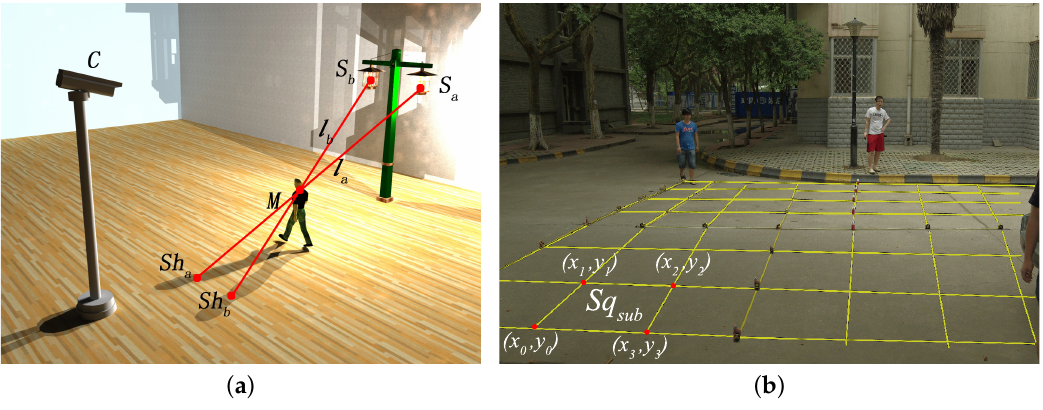
Figure 1. Demo of silhouetted shadow-based skeleton extraction (SSSE) in a multi light source scenario: ( a ) A simulated dual light source scenario; ( b ) Scenario